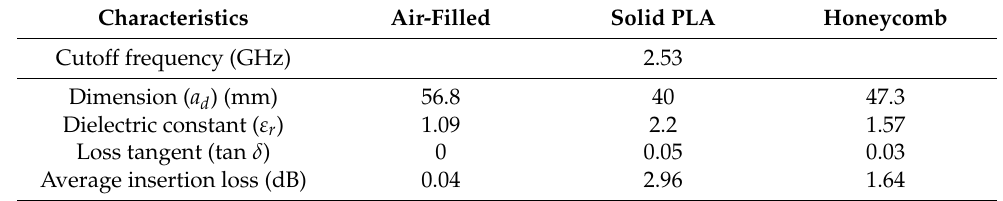
Table 1. Comparison of SIW characteristics between air-filled, solid PLA and the proposed honeycomb. Characteristics Air-Filled Solid PLA Honeycomb Cutoff frequency